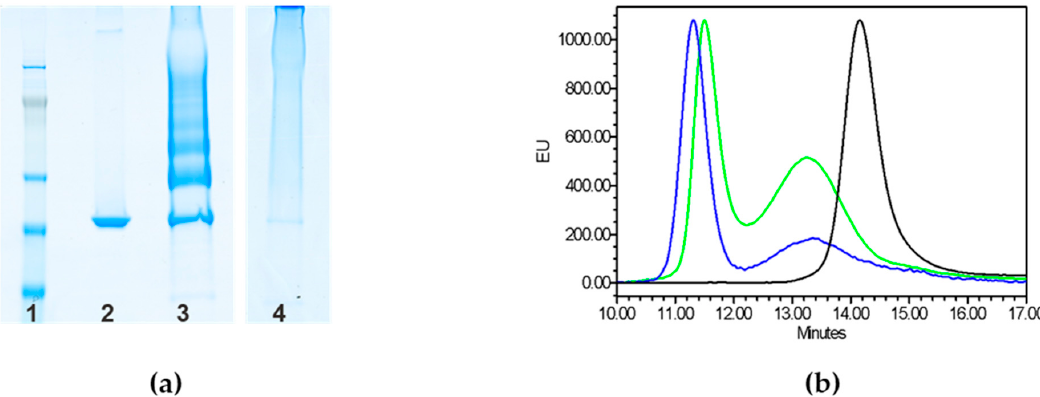
Figure 2. ( a ) Characterization by sodium dodecyl sulfate-polyacrylamide gel electrophoresis (SDS-PAGE) analysis (7% Tris-acetate gel) of the conjugation mixtures in comparison to unconjugated CRM 197 . Ten µg of conjugated protein and 2 µg of unconjugated CRM 197 were loaded per well. Lane 1: marker, lane 2: CRM 197 , lane 3: selective GAC-CRM 197 , lane 4: random GACox-CRM 197 . ( b ) HPLC-SEC profiles (fluorescence emission detection) of selective GAC-CRM 197 conjugation mixture (blue line), random GACox-CRM 197 conjugation mixture (green line) and unconjugated CRM 197 (black line), 80 µL of sample injected on a TSK gel G3000 PW XL column; 0.1 M NaCl 0.1 M NaH 2 PO 4 5% CH 3 CN pH 7.2 at 0.5 mL/min. Vtot 23.326 min, V0 10.663 min.